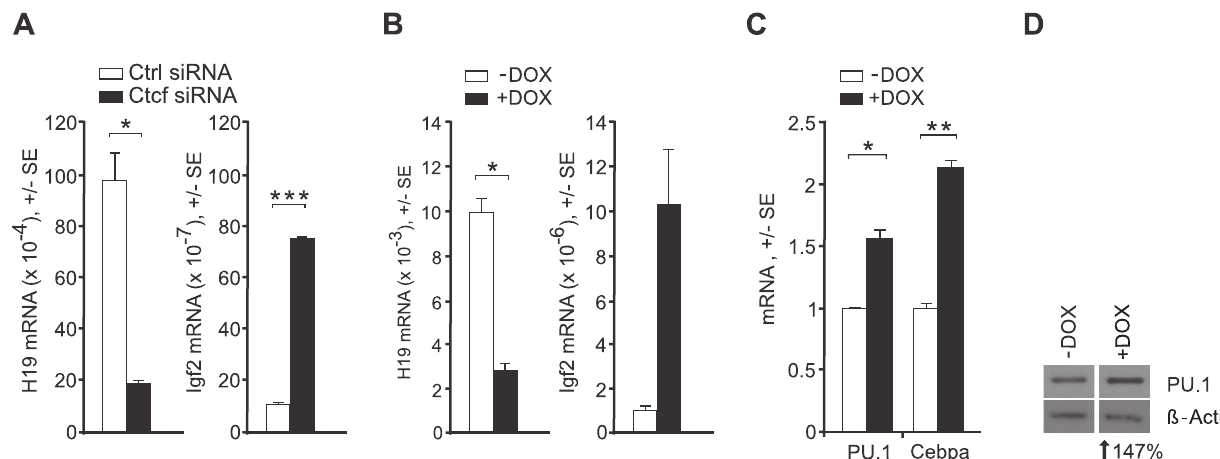
Figure 3. Smarca5 regulates Ctcf target genes. A: H19 and Igf2 mRNA expression upon Ctcf knockdown (Ctcf siRNA) or Ctrl siRNA. B: Smarca5 knockdown ( + DOX) compared to untreatment (-DOX). RT-PCR analyses (A&B) were done at 72hrs. Y-axis: specific mRNAs relative to Hprt1 levels. C: mRNA levels of PU.1 and Cebpa at 96 hrs (4 days) upon Smarca5 knockdown. Y-axis: specific mRNA relative to average of Hprt1 and Gapdh was normalized on negative control (non-specific siRNA). Error bars: the standard errors (SE). Asterisks: p-values (t-test, 0.05–0.005). D: PU.1 and b -actin expression determined by Immunoblotting at 144 hrs (6 days) upon Smarca5 knockdown. Level of downregulation (bellow blots) was determined by densitometry.